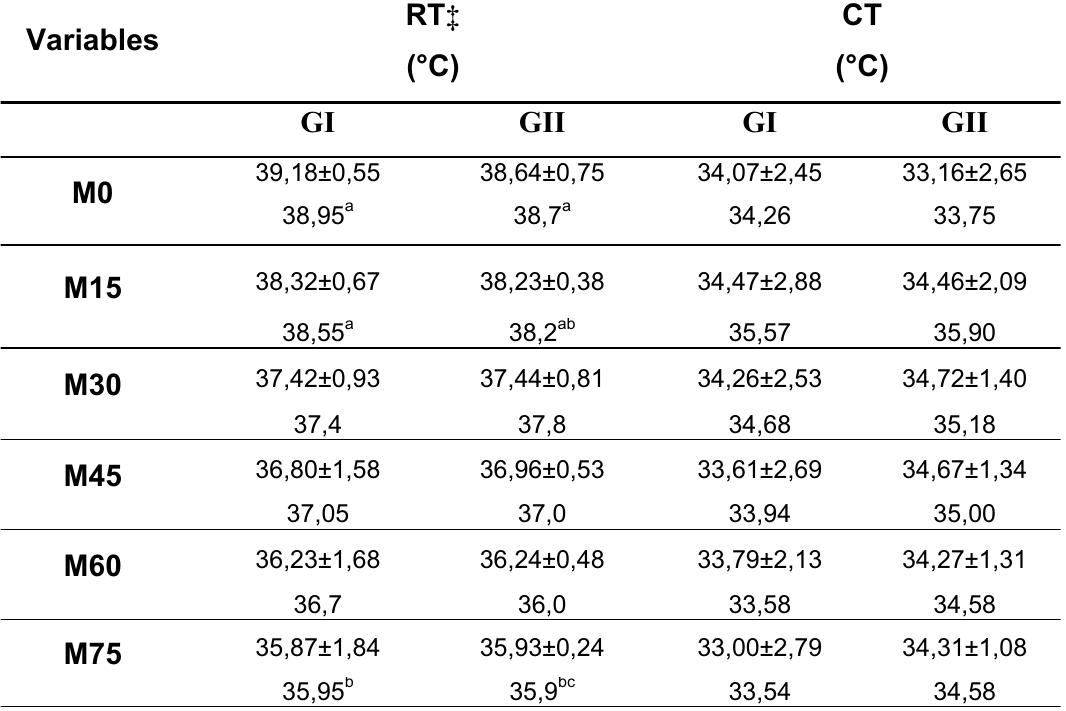
TABLE 1 - Distribution of means ± standard deviations and medians, according to the group (GI – control and GII – SAF) for the clinical parameters rectal temperature (RT) and cutaneous temperature (CT) in bitches submitted to general inhalatory